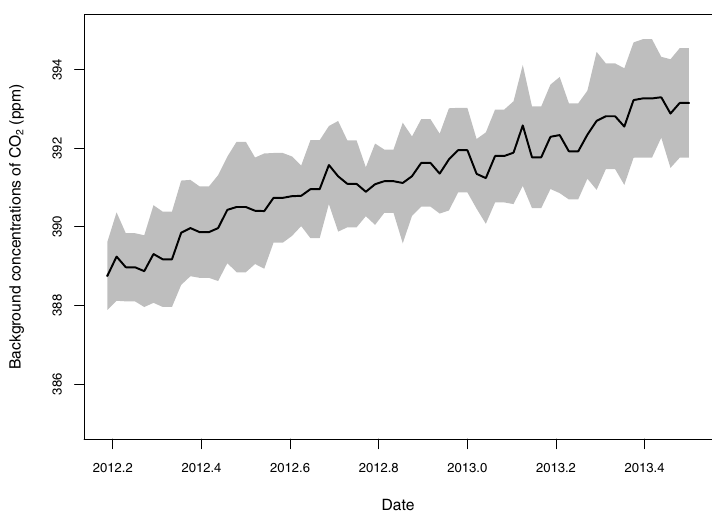
Figure 2. Weekly mean background concentrations of CO 2 (ppm) as measured at Cape Point GAW station, with 95% confidence interval represented by the grey shaded area. The mean concentrations are calculated from percentile filtered observations, extracting only those observations considered to be representative of background